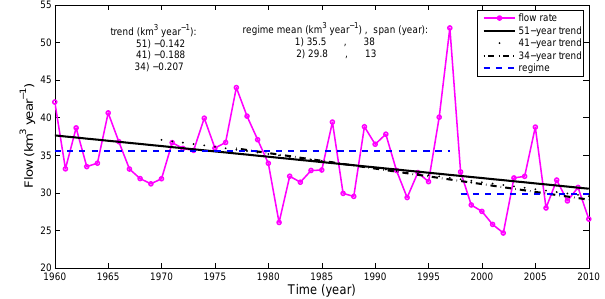
Fig. 7. Input flow rate to Lake Athabasca from other small rivers Fig.7. InputflowratetotheLakeAthabascafromothersmallriversandthedetectedtrendsforthreedifferentanalysisperiods.Thesetrends arenotsignificant( p -value ≥ 0.10). and the detected trends for three different analysis periods. These trends are not significant ( p value ≥ 0.10).